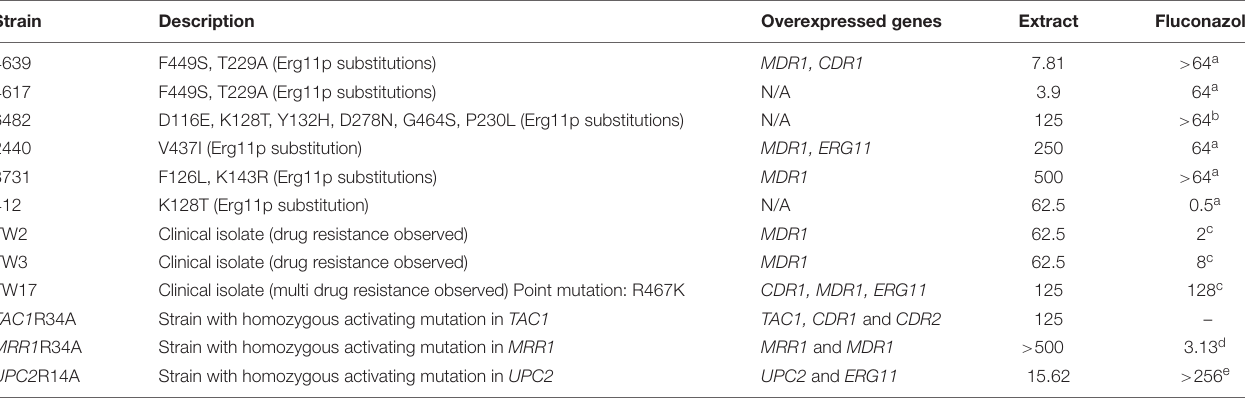
TABLE 2 | Results (MIC values) of in vitro susceptibility testing of the free extract against C. albicans clinical isolates displaying different mechanisms of azole resistance and against laboratory generated strains with activating mutantions in key genes involved in azole resistance. Strain